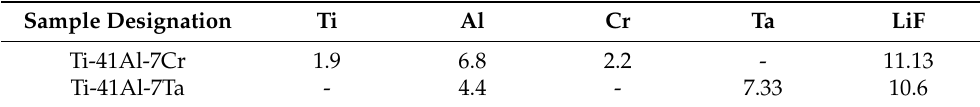
Table 1. Compositions of the powder mixtures, g.